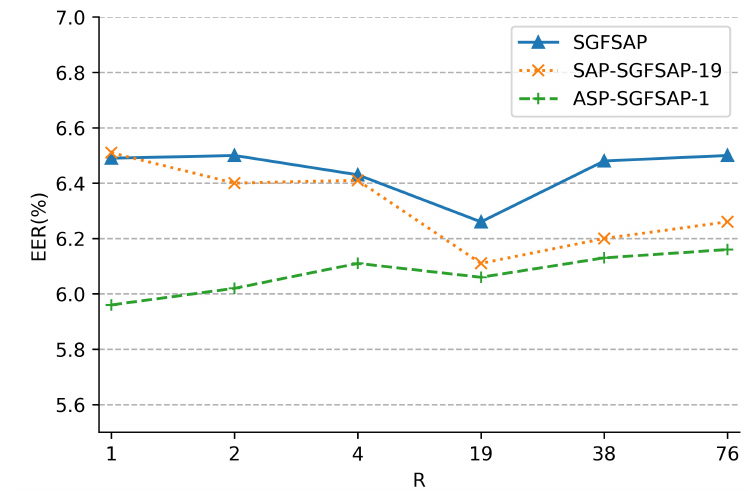
Figure 4. The effectiveness of grouping method (EER versus R ).